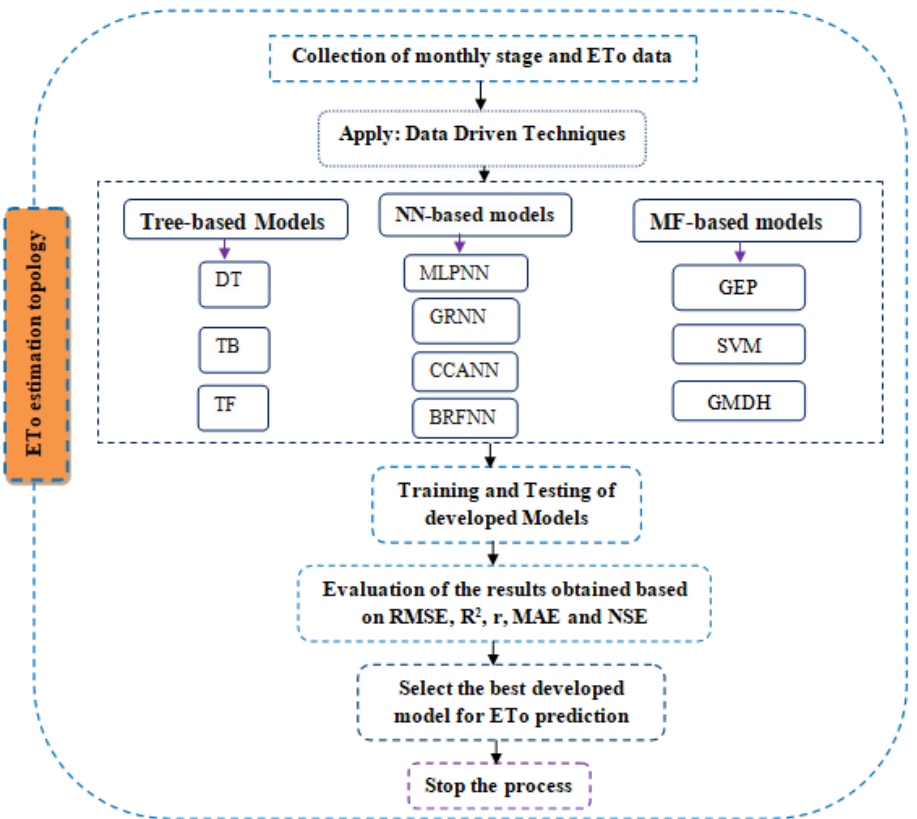
Figure 6. Proposed ML flowchart for ET o modeling.